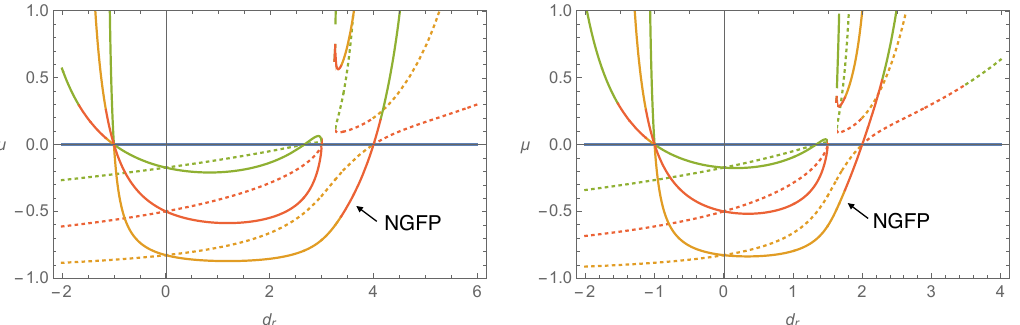
Figure 2 . Comparison of the fixed point solutions ¯ µ ∗ as a function of dimension d r at truncation order n = 4 without anomalous dimension, η k ≡ 0 , for the FRG equation (3.18) (continuous curves) compared to the large- N equation of O ( N ) models (i.e. without the factor 1 /r , dashed curves), for ζ = 1 (left) and ζ = 1 / 2 (right). Different colours are due to different algebraic roots but only the continuous curves are relevant here. The Wilson-Fisher type fixed point corresponds to the solution branch which has ¯ µ ∗ = 0 at the critical dimension d r = d crit = 4 ζ . In contrast to O ( N ) models, we have another zero of ¯ µ ∗ at d r = r − 1 = − 1 which, however, is neither a physical dimension nor